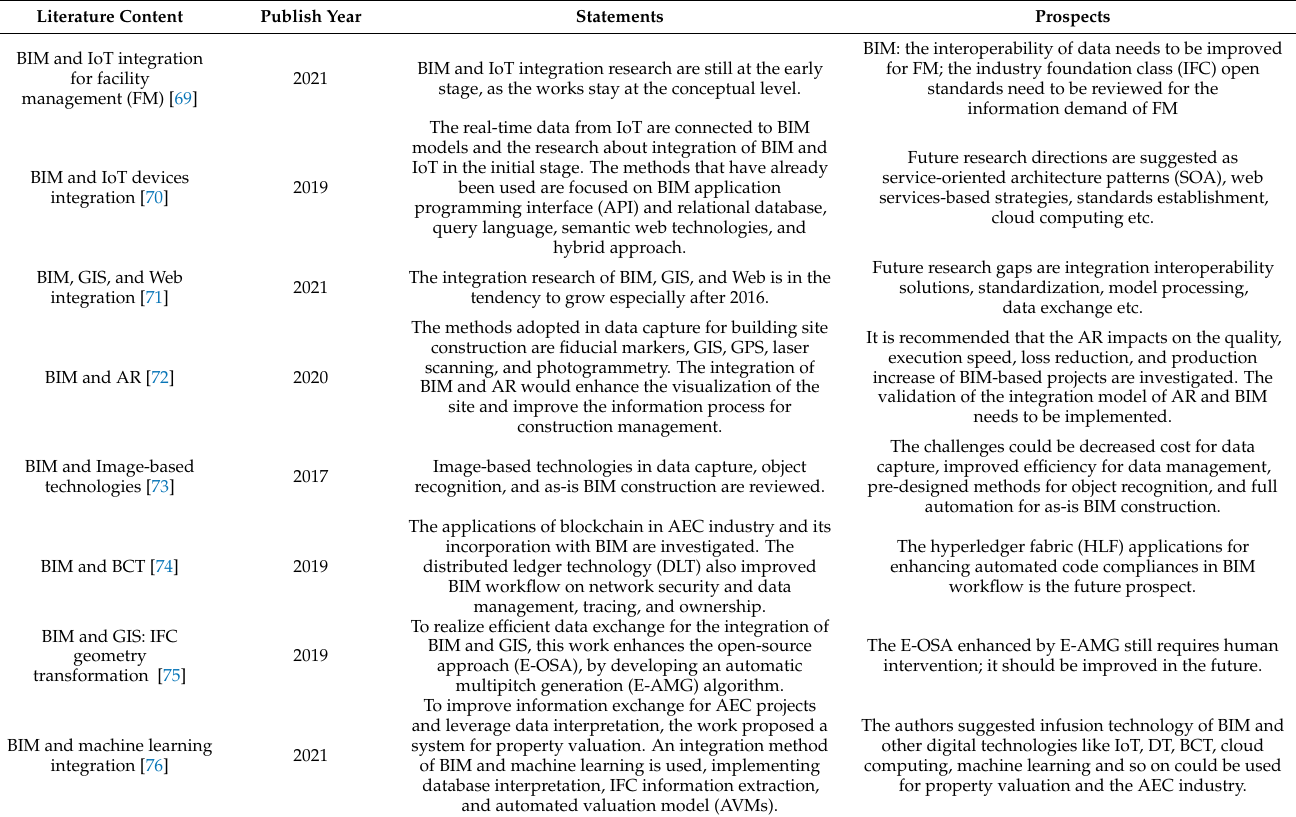
Table 4. Selected publications about the integration of BIM, GIS, and other analytic